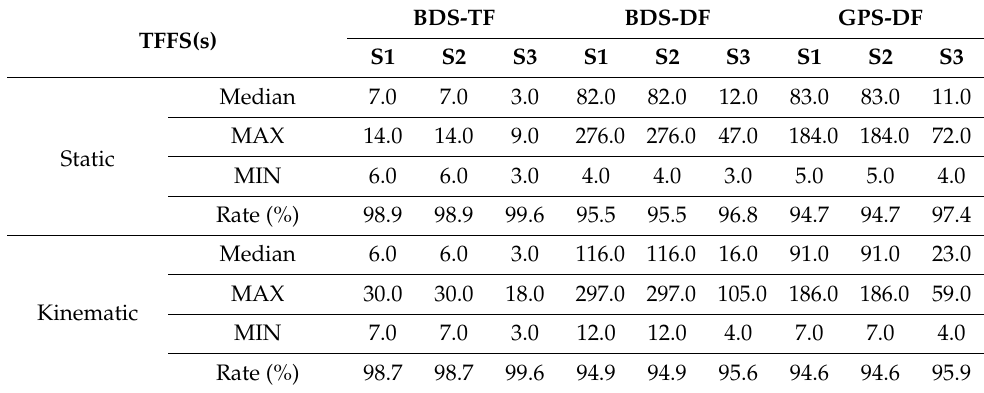
Table 5. Statistics of ambiguity fixing performance of Baseline C2, Sampling rate 1